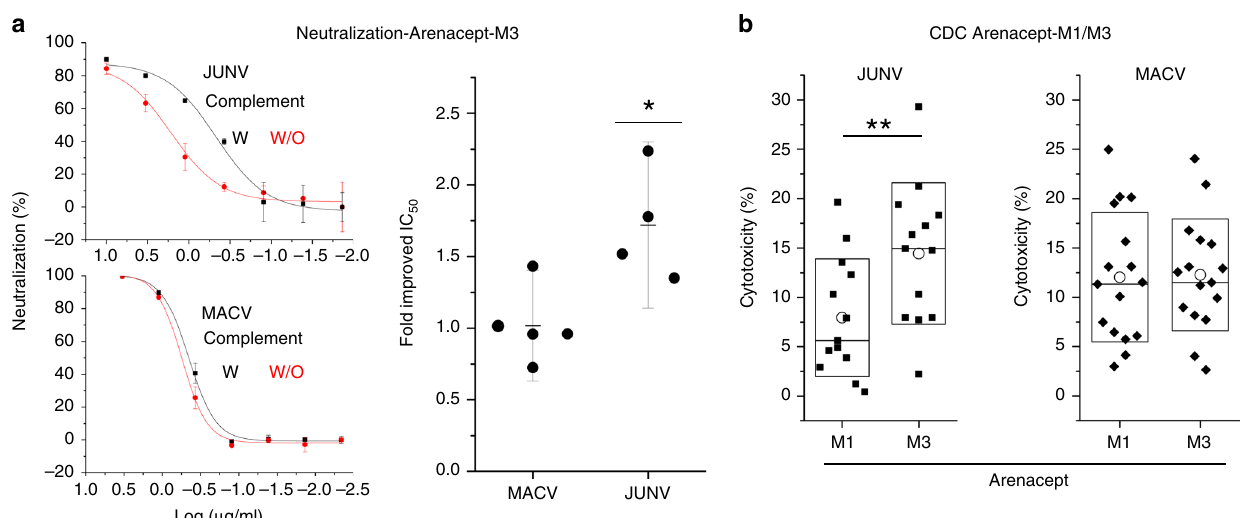
Fig. 6 Complement mediated enhancement of Arenacept. a Complement augments direct neutralization of Arenacept-M3. Neutralization of JUNV- and MACV-pseudotyped viruses was tested with or without 2.5% complement. Representative neutralization curves are shown (left). Error bars indicate standard deviations of technical replicates. Fold improvement of IC 50 values in the presence of 2.5% complement is indicated (right). Each dot represents the fold change between a pair of independent neutralization experiments, with or without complement. Improvements in IC 50 values are not signi fi cant for MACV ( n = 5 independent experiments), but are signi fi cant for JUNV ( n = 4 independent experiments, * indicates p < 0.05, Student ’ s two-tailed t test). b Arenacept activates complement. Cytotoxicity mediated by complement activation on HEK293T cells that transiently display the spike complex of JUNV (left) or of MACV (right). Cell killing was determined at Arenacept concentration of 10 μ g/ml Arenacept-M1 or Arenacept-M3, as indicated. The difference in cytotoxicity between Arenacept-M1 and Arenacept-M3 in the case of JUNV is signi fi cant ( n = 13 technical repeats, ** indicates p < 0.005, Student ’ s two- tailed t test). These are representative experiments out of three independent repeats. Boxes indicate standard deviations of technical repeats. Median and average values are indicated with horizontal lines and open circles, respectively. For all relevant panels, source data are provided as a source data fi